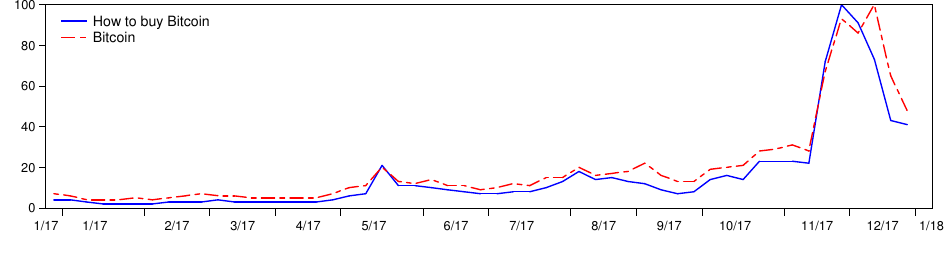
Figure 3. Google Trends Year of Search 2017.